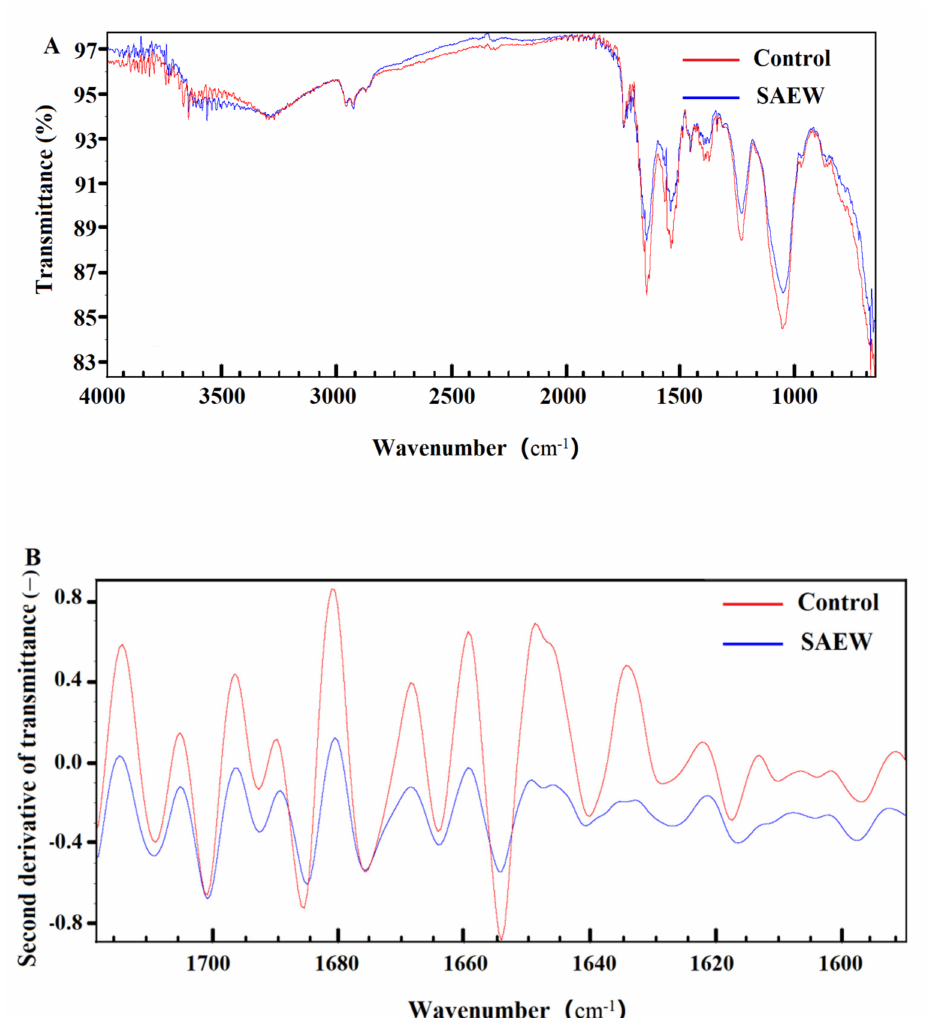
Figure 4. Fourier-transform infrared spectroscopy (FTIR) evaluation on the L. monocytogenes treated by SAEW(slightly acidic electrolyzed water) including ( A ) original FTIR graph and ( B ) the correspond- ing second derivative infrared spectra graph. SAEW with ACC(available chlorine concentration) of 6.03 ± 0.13 and pH of 5.76 ± 0.03 was used for 60 s in the